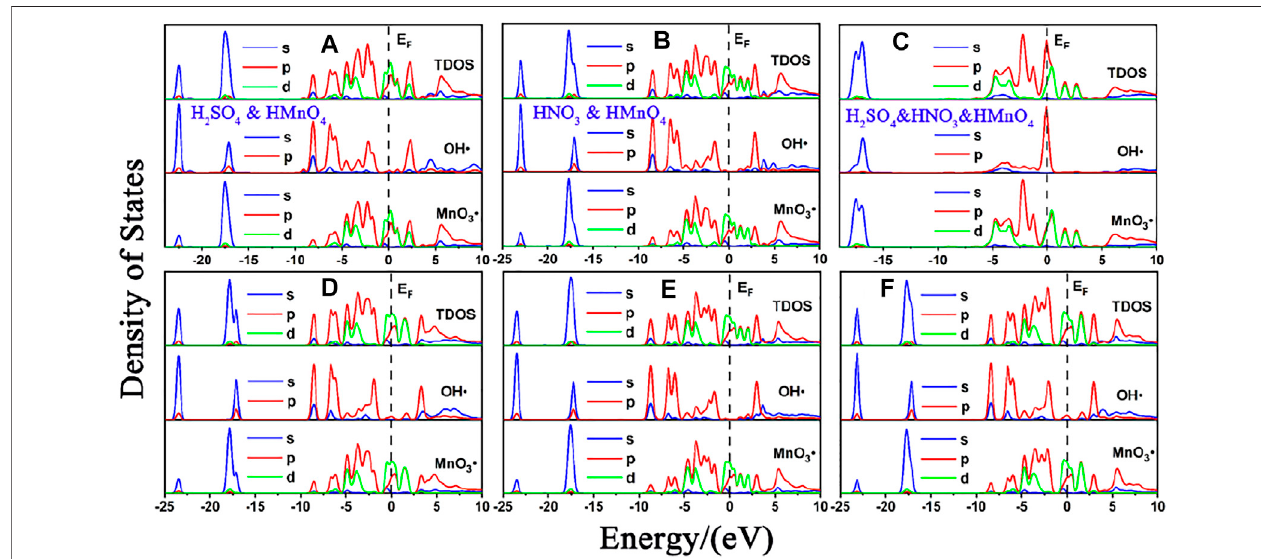
FIGURE 9 | DOS of mix-component acid molecules in aqueous condition. (A) , (B) and (C) are the DOS of HMnO 4 in the case of H 2 SO 4 and HMnO 4 , HNO 3 and HMnO 4 and H 2 SO 4 and HNO 3 and HMnO 4 on non-defect graphene, respectively. (D) , (E) and (F) are the DOS of HMnO 4 in the case of H 2 SO 4 and HMnO 4 , HNO 3 and HMnO 4 and H 2 SO 4 and HNO 3 and HMnO 4 on Stone-Wales defect graphene, respectively. In each diagram, the top represents the TDOS, the middle represents the (cid:129) (cid:129) LDOS pf MnO 3 and the bottom represents the LDOS of OH .